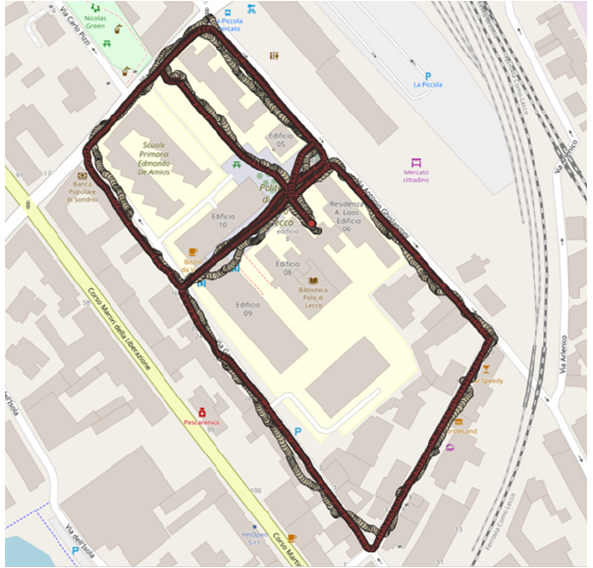
Figure 6: Results for the Lecco dataset: mobile phone recorded path (yellow) and trajectory after bundle adjustment